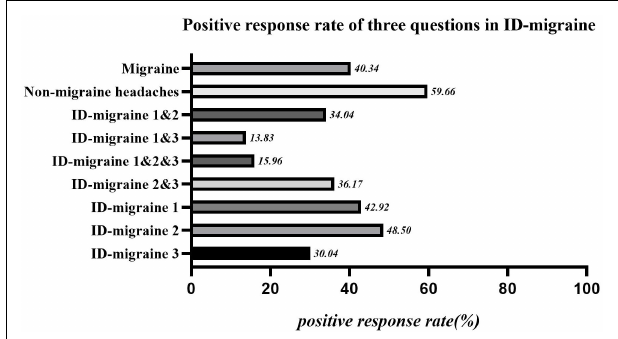
FIGURE 2 | Positive response rate of three questions in ID-migraine. ID-migraine 1: If there is one day or more you can’t work, study, or do daily activities normally because of headache?; ID-migraine 2: Is there nausea or stomach upset during headache?; ID-migraine 3: Is there photophobia companied with headache?